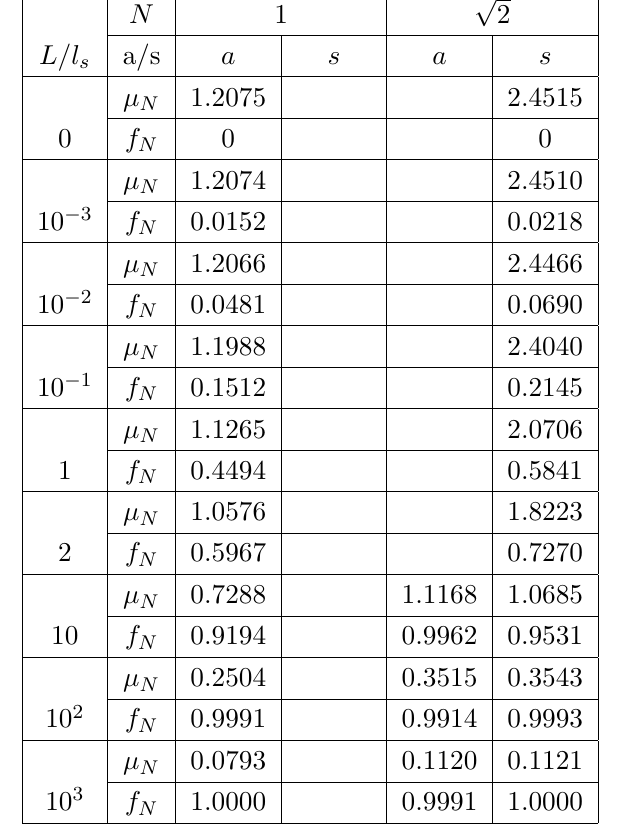
Table 3. The (cid:12)rst modes of the Kaluza-Klein spectrum for d = 3, in terms of their deviation f N (4.20) from the standard spectrum. An empty cell means that the mode has not been found within the search